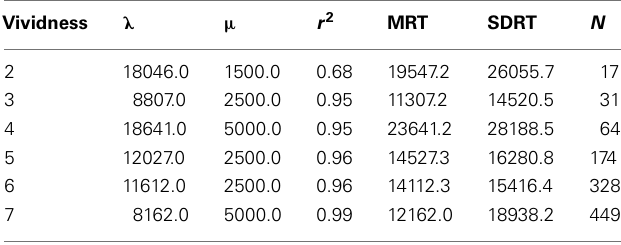
Table 1 | Results of the ex-Gaussian fit to empirical image latency distributions in unconstrained image generation phase of Experiment